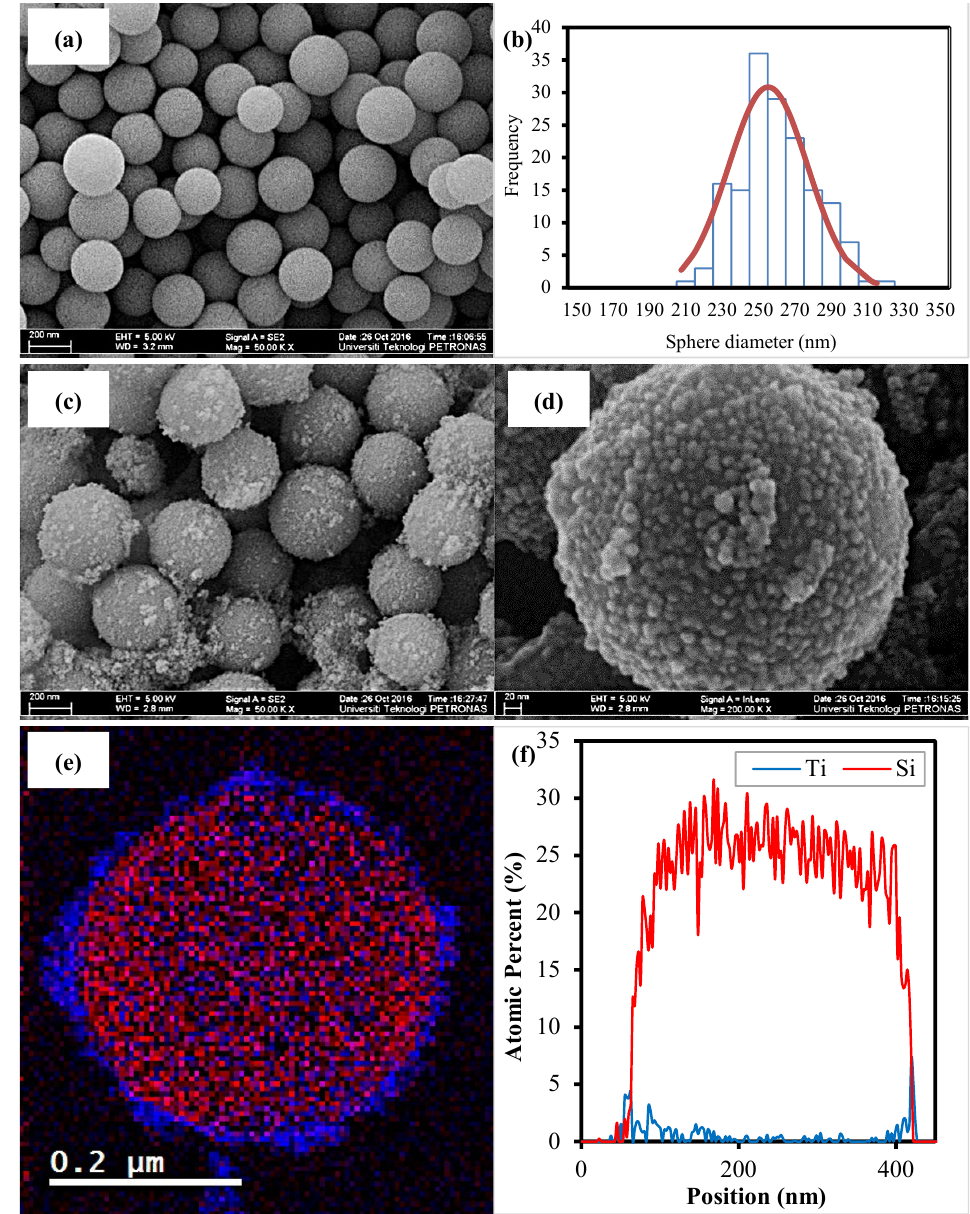
Figure 4. ( a ) FESEM image of the synthesized SiO 2 sphere, ( b ) size distribution of the synthesized SiO 2 sphere, ( c ) FESEM image of SiO 2 coated with TiO 2 at a magnification of 50 kX, ( d ) FESEM image of SiO 2 coated with TiO 2 at a magnification of 200 kX, ( e ) EELS dot mapping of the SiO 2 -TiO 2 core-shell sphere and ( f ) EDX line scan of SiO 2 -TiO 2 core-shell sphere.